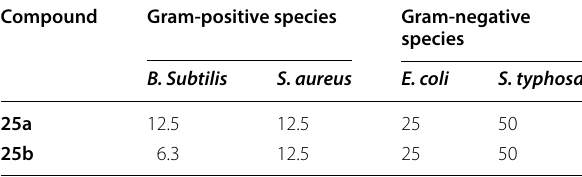
Minimum Inhibitory Concentrations was expressed as (µg/ml)